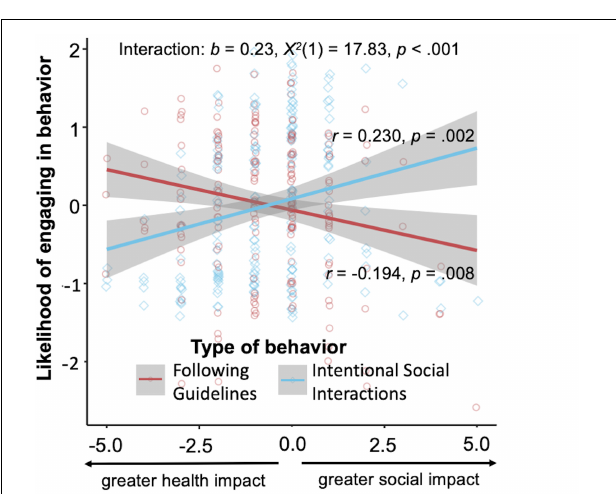
FIGURE 2 | Association between relative expected impact of the pandemic in social vs. health domains and the likelihood of engaging in types of behaviors as defined by the following guidelines and intentional social interactions factor scores. As participants expected a higher social, as compared to health, impact, they reported that they would be more likely to interact with others and less likely to follow other (not interaction-related) recommended guidelines. Error bars represent standard error of the